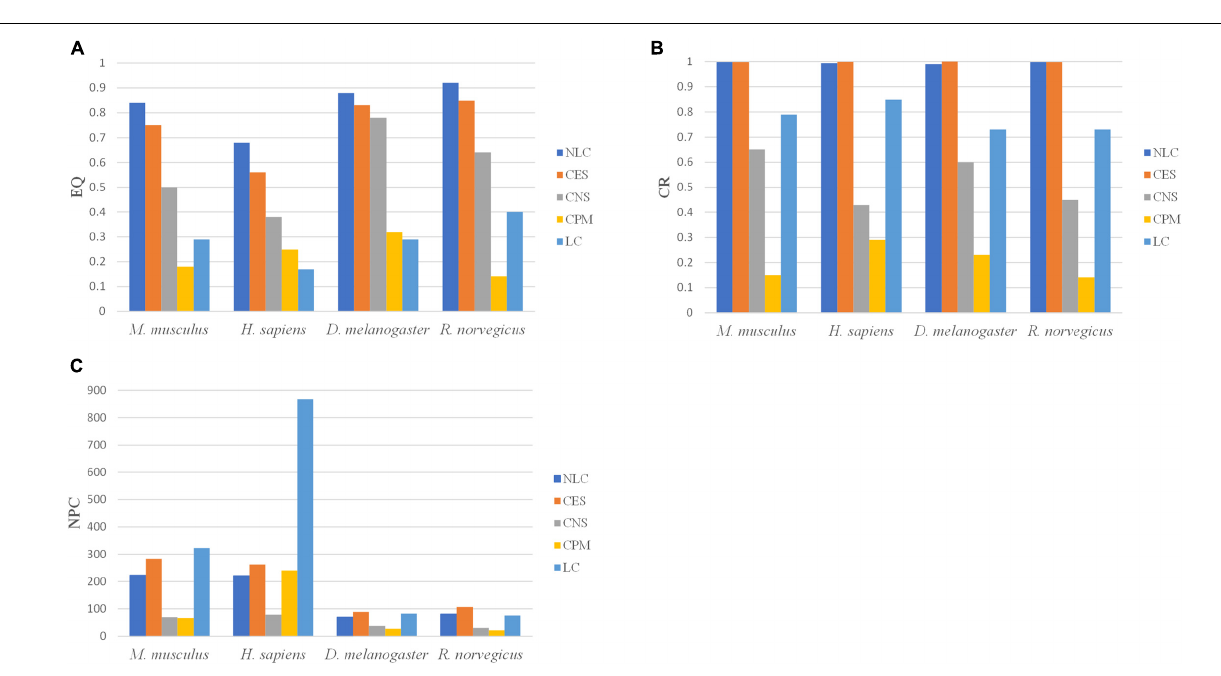
Frontiers in Genetics |